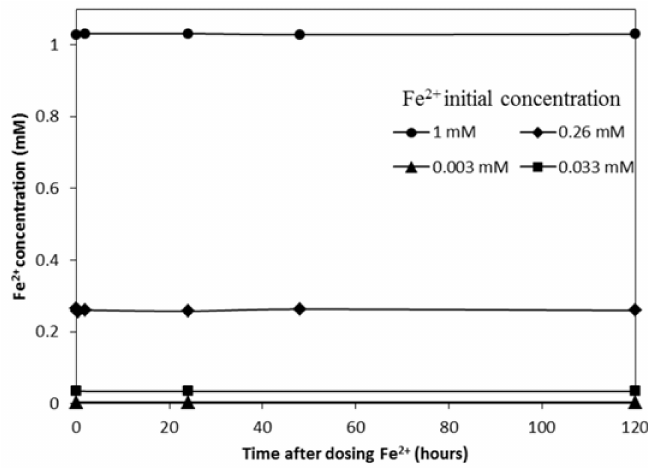
Figure 2. Fe 2+ concentrations over 120 h contact time in reactors with Fe 2+